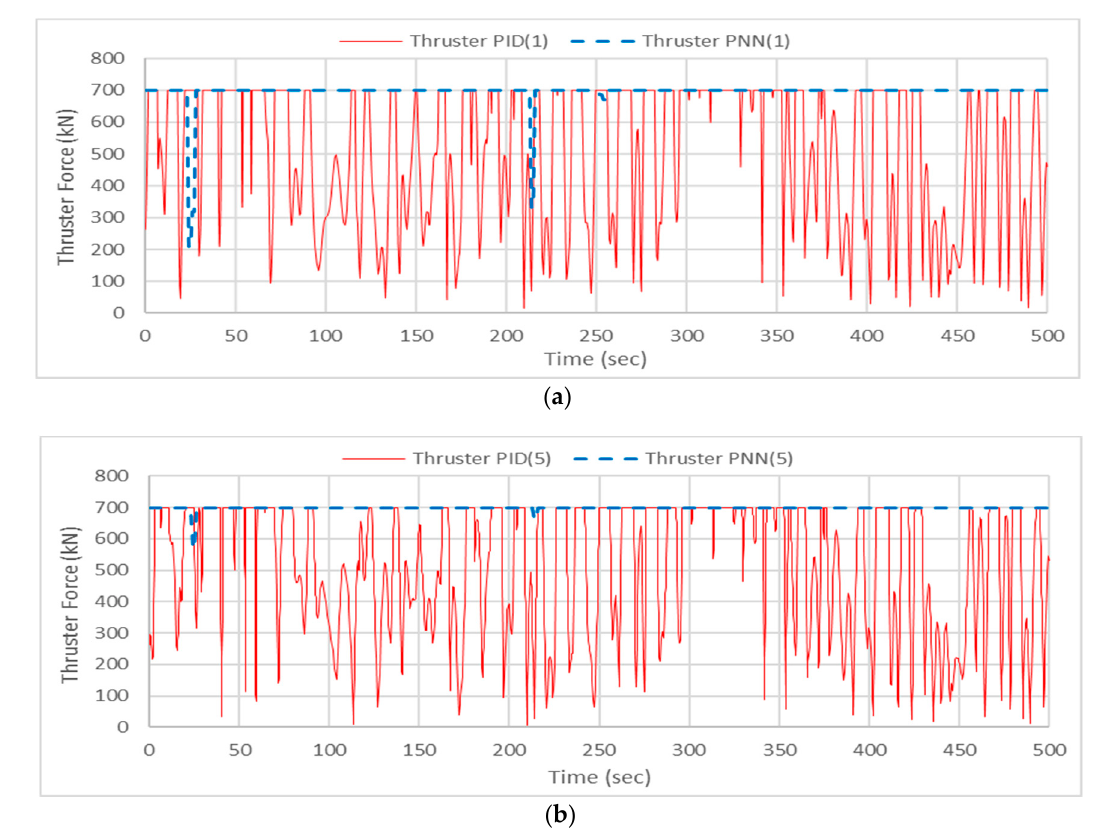
Figure 21. DP simulation with PID and PNN controls showing platform heading (Beam sea).